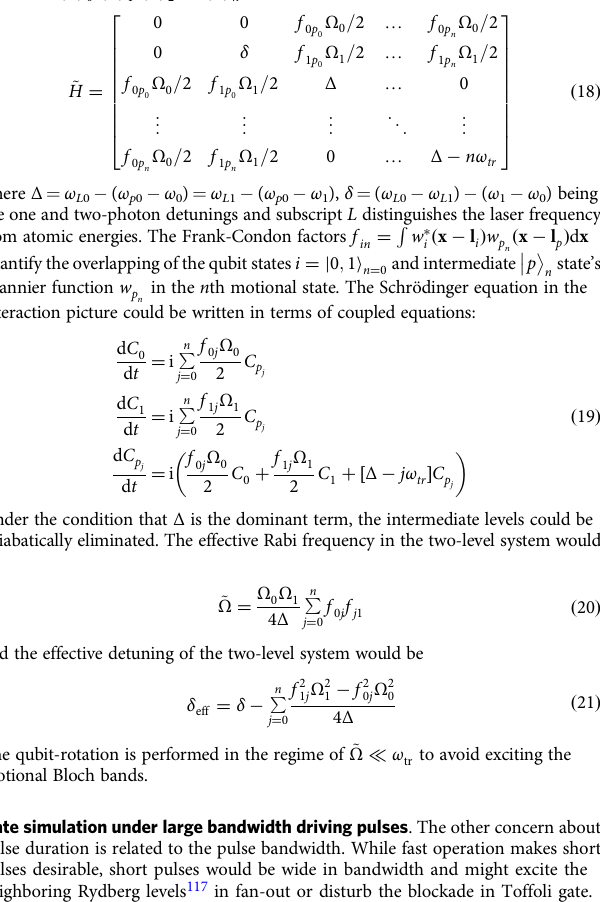
. The averaged error of the central atom (cid:1) E c is plotted by dashed